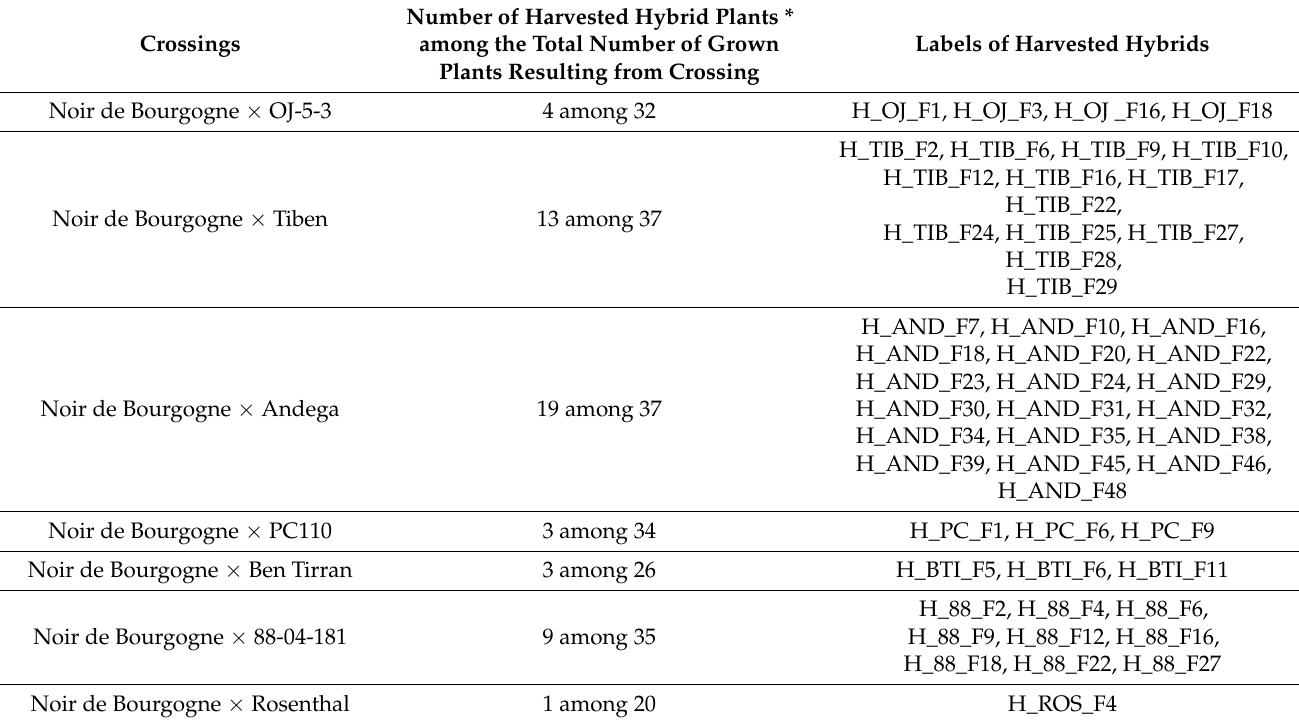
Labels of Harvested Hybrids